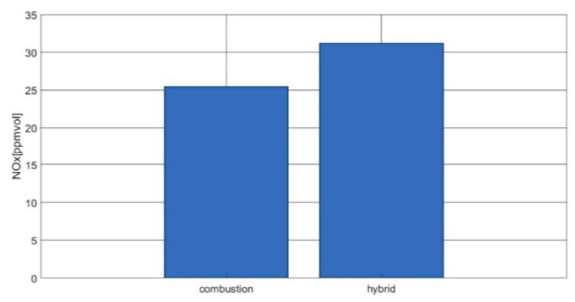
Fig. 16. The NO x emission for propulsion units